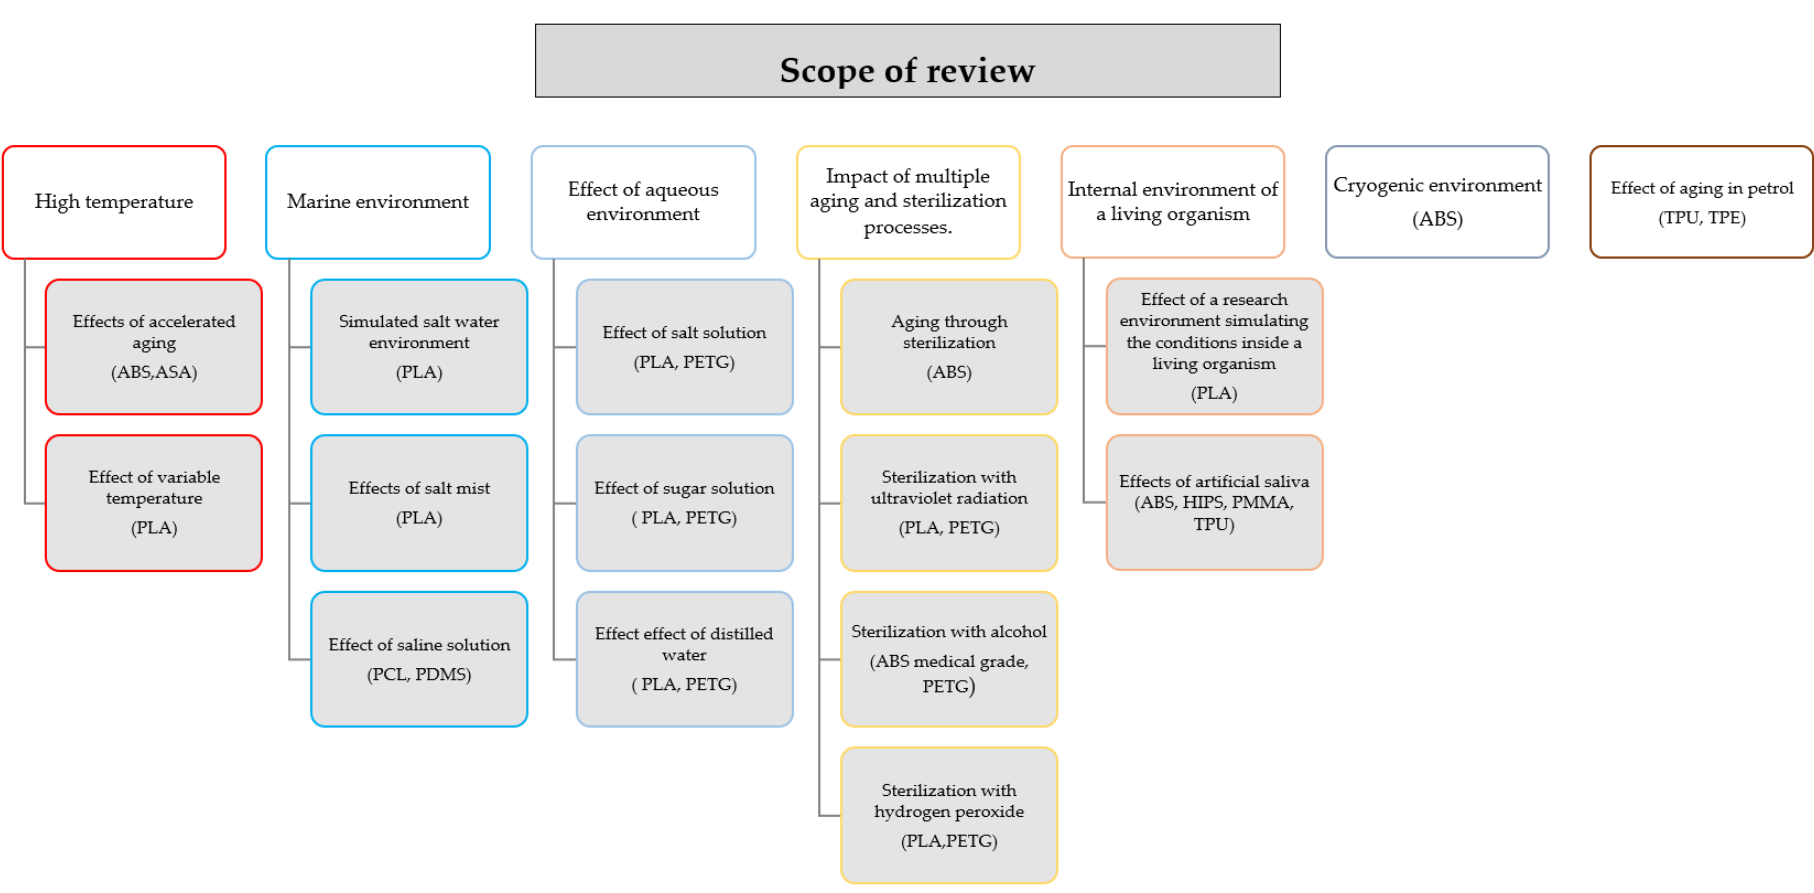
Figure 1. The range of subjects discussed in the review, along with the materials.